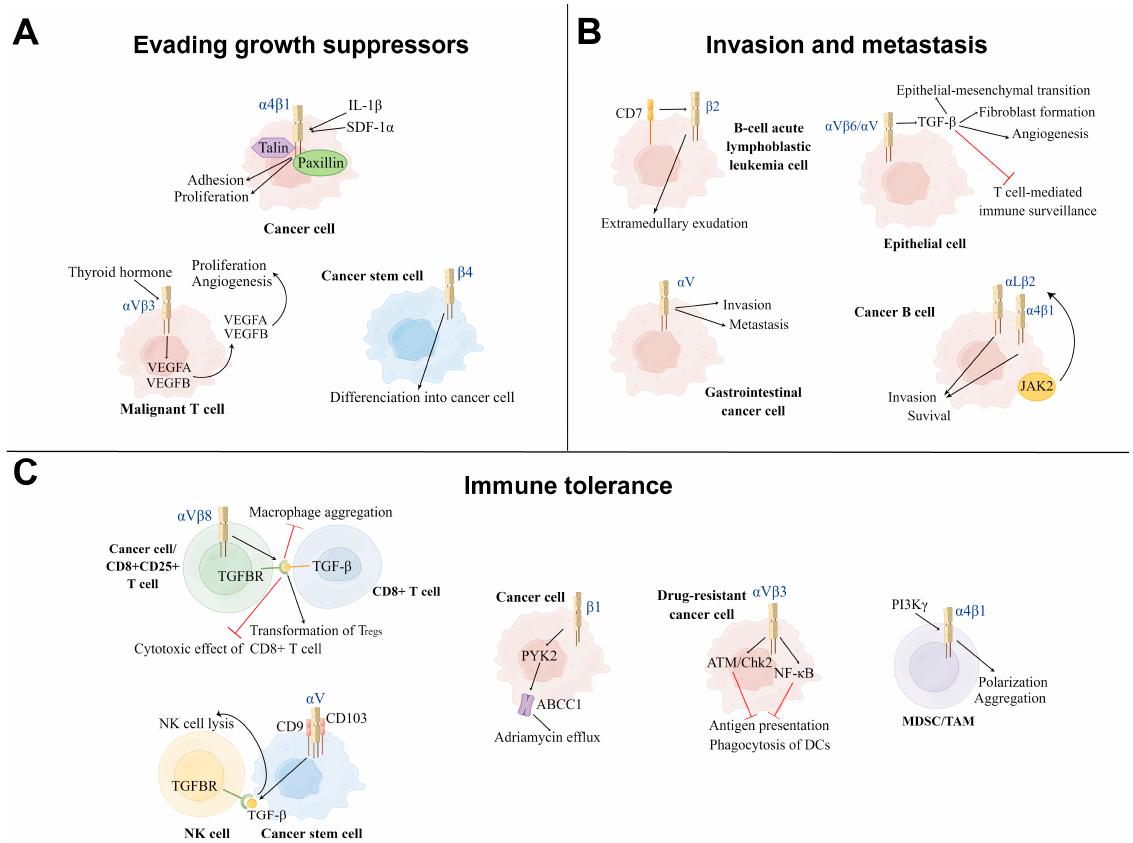
Figure 3. Three main mechanisms of positive modulation of integrins on cancer development. ( A ): Evading growth suppressor: Integrins can achieve evading growth suppressor by promoting cancer cell proliferation, differentiation, aggregation, and angiogenesis in the tumor microenvironment (TME). Under the influence of thyroid hormone, α V β 3 Integrins promote the proliferation and angiogenesis of the malignant T cell. The cytokines IL-1 β and SDF-1 α induce α 4 β 1 integrins to interact with talin and paxillin to facilitate tumor growth. β 4 integrins promote the differentiation of cancer stem cells into tumor cells. ( B ): Invasion and metastasis: Integrins mediate the invasion and metastasis of different types of cancer cells to other sites, leading to disease deterioration. β 2 integrins and α V integrins promote, respectively, the invasion and metastasis of B-cell acute lymphoblastic leukemia cells and gastrointestinal cancer cells. α V integrins on the surface of epithelial cells can reshape the TME via activating TGF- β . The cancer B-cell in B-cell chronic lymphocytic leukemia (B-CLL) increases its survival and invasion by the activation of α L β 2 and α 4 β 1 integrins via the JAK2 pathway. ( C ): Immune tolerance: Part of integrins on cancer cells inhibit the function of immune cells from achieving immune tolerance. α V β 3 integrins on the drug-resistant cancer cells